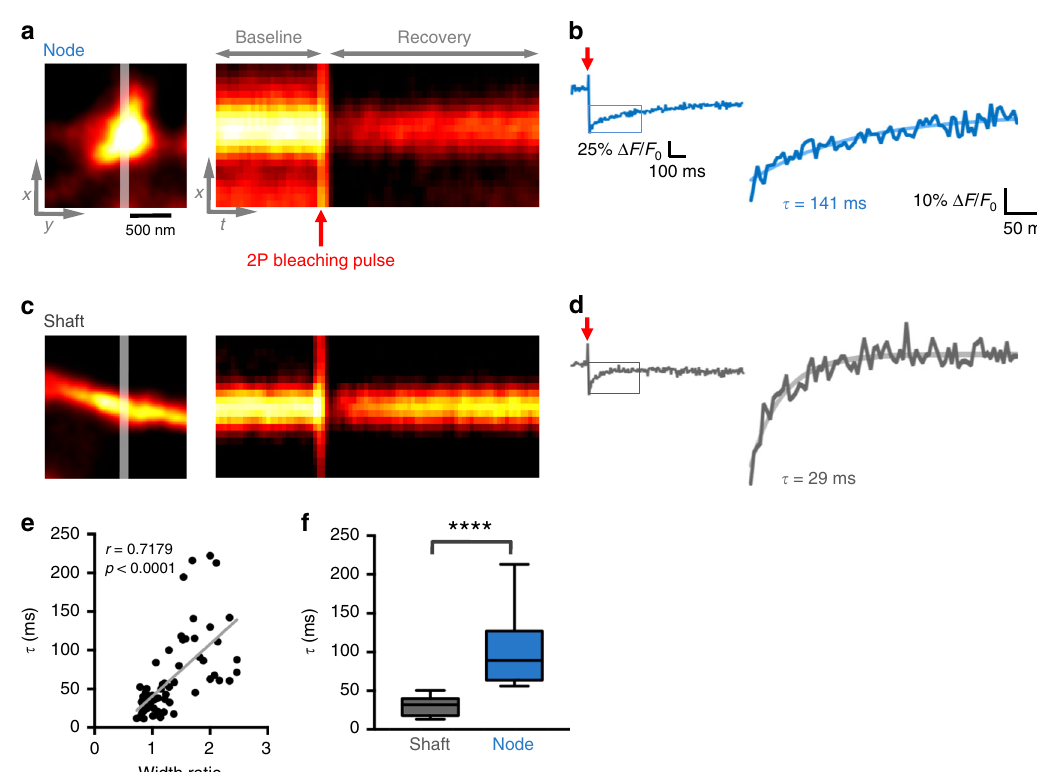
Fig. 5 Astrocytic nodes are biochemically compartmentalized. a , c An example of node ( a ) and shaft ( c ). White line indicates the site of imaging and 2P bleaching (left). Fluorescence recovery over time. Red arrow indicates the timing of 2P bleaching (right). b , d FRAP traces obtained from experiments shown in ( a , c ), showing the recovery of fl uorescence normalized to the fl uorescence before bleaching. Single exponential equation used for the fi t is overlaid with the original trace. e Correlation between width ratio (Node or shaft width at the bleach location/shaft width 1 μ m away from the bleach location) and τ ( n = 66 structures from 7 slices; Spearman r = 0.7179, **** p (two-tailed) < 0.0001). Higher width ratio was associated with longer τ . f Comparison of τ between nodes ( n = 27) and shafts ( n = 39), indicating that the anatomical parameters of nodes shaped the degree of compartmentalization (Mann – Whitney U test, **** p (two-tailed) < 0.0001,). Data are presented as median, interquartile range, and whiskers 10 –